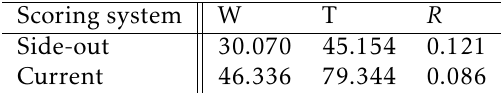
Table 3. Measures of game refinement for